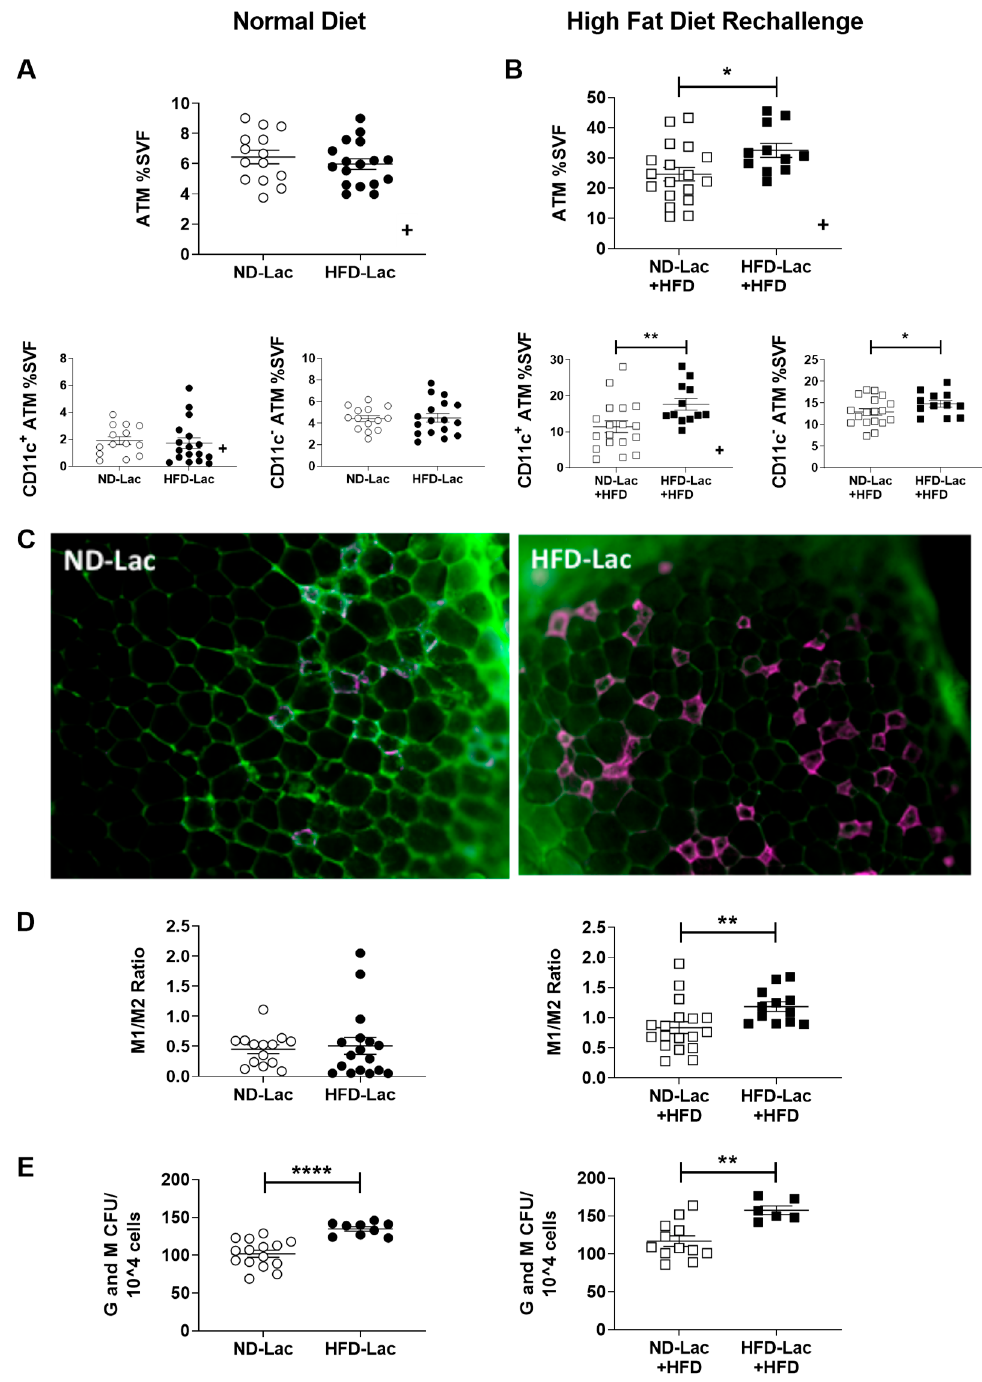
Figure 4. Enhanced myeloid inflammation in Lac-HFD males challenged to HFD. Data collected from six-month-old males on either a normal diet or high-fat diet ( + HFD). Total adipose tissue macrophages (ATMs), CD11c + ATMs and CC11c − ATMs in GWAT of males fed a normal diet ( A ) or fed HFD ( B ). Representative immunofluorescent images of crown-like structure formation in GWAT (Green Caveolin, Magenta Mac2) ( C ). Ratio of pro-inflammatory M1 to anti-inflammatory M2 macrophages in GWAT ( D ). Granulocyte and monocyte colony forming units from bone marrow ( E ). * p < 0.05, ** p < 0.01, **** p < 0.0001. + indicates a significant interaction between lactation exposure and HFD re-challenge within the analyzed endpoint.